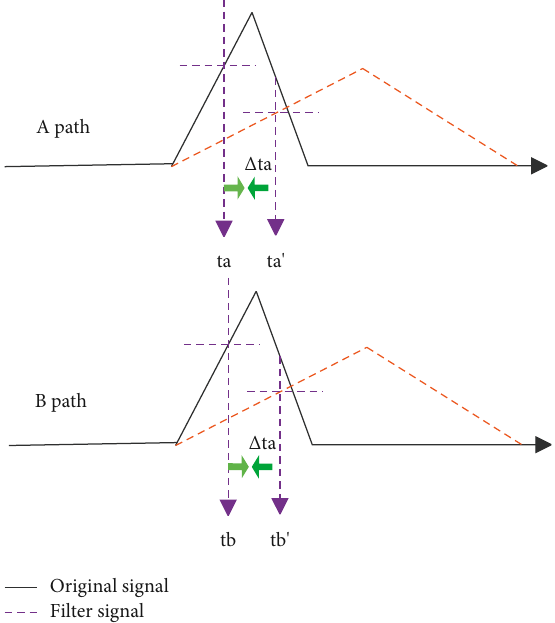
Figure 9: Schematic diagram of waveform broadening.